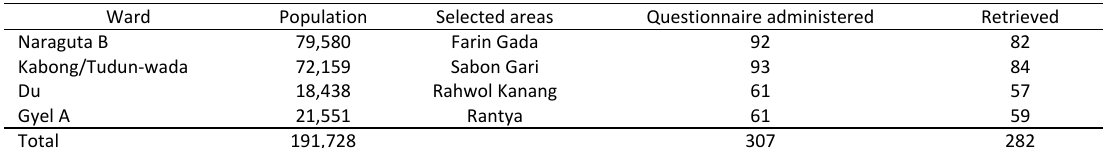
Table 2: The selected peri-urban areas